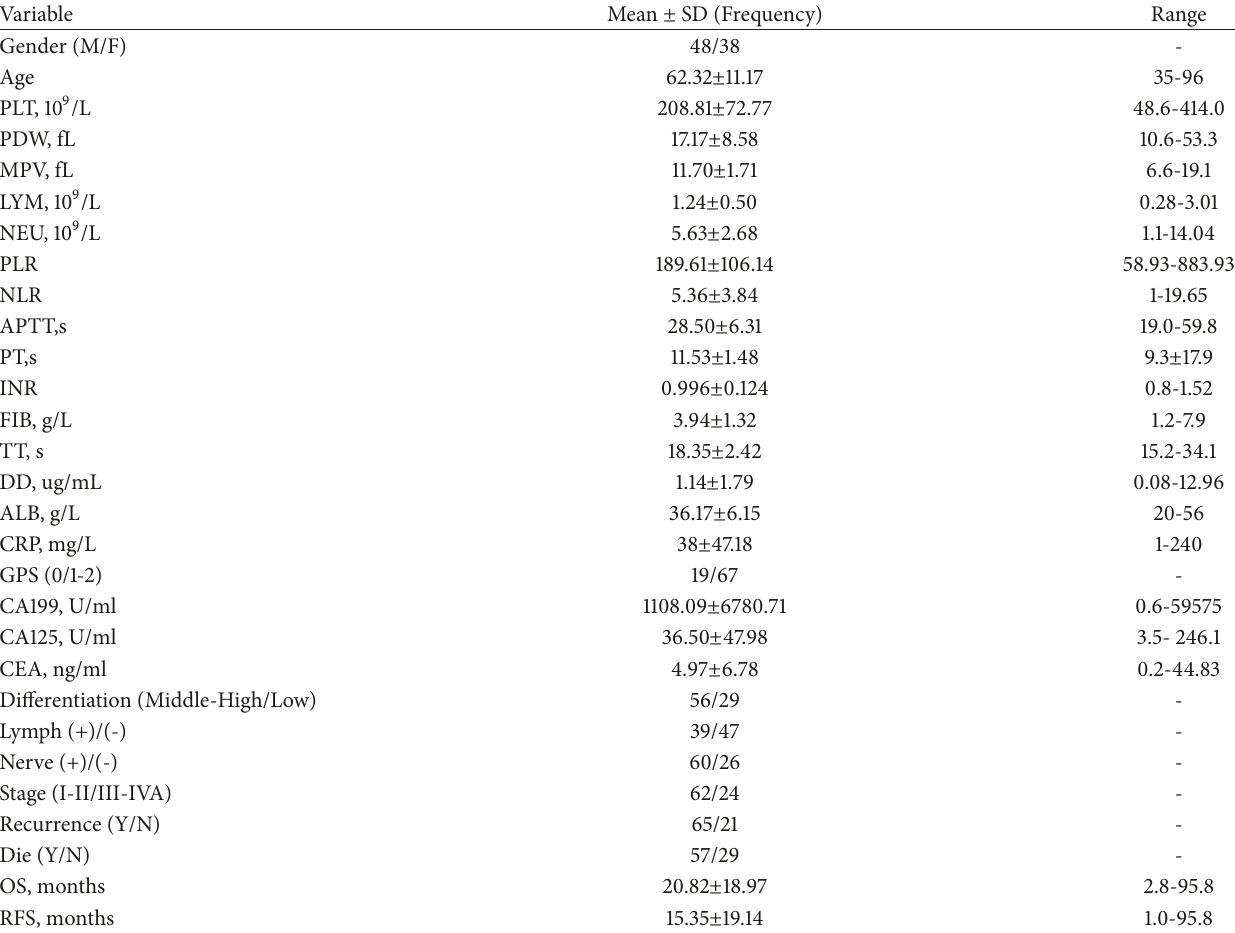
Table 1: Demographics and clinical characteristics of patients with